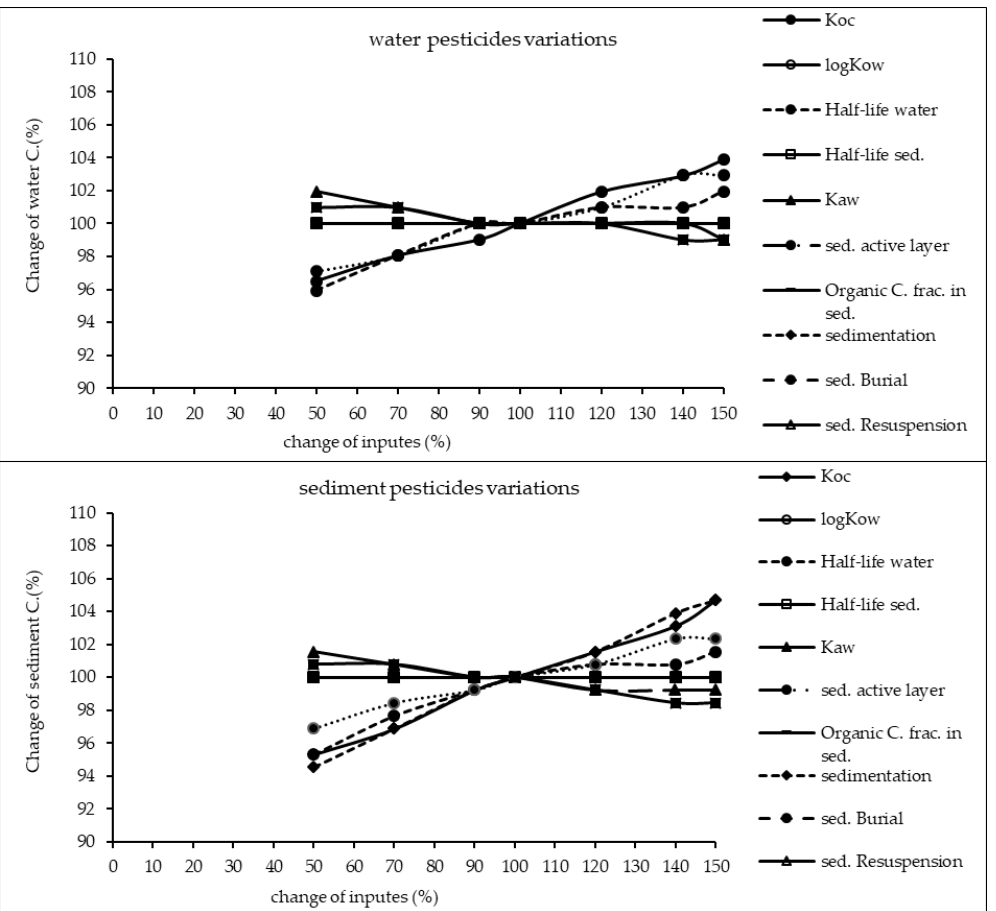
Figure 2. Results of the sensitivity analysis for α-HCH in Lake Naivasha.